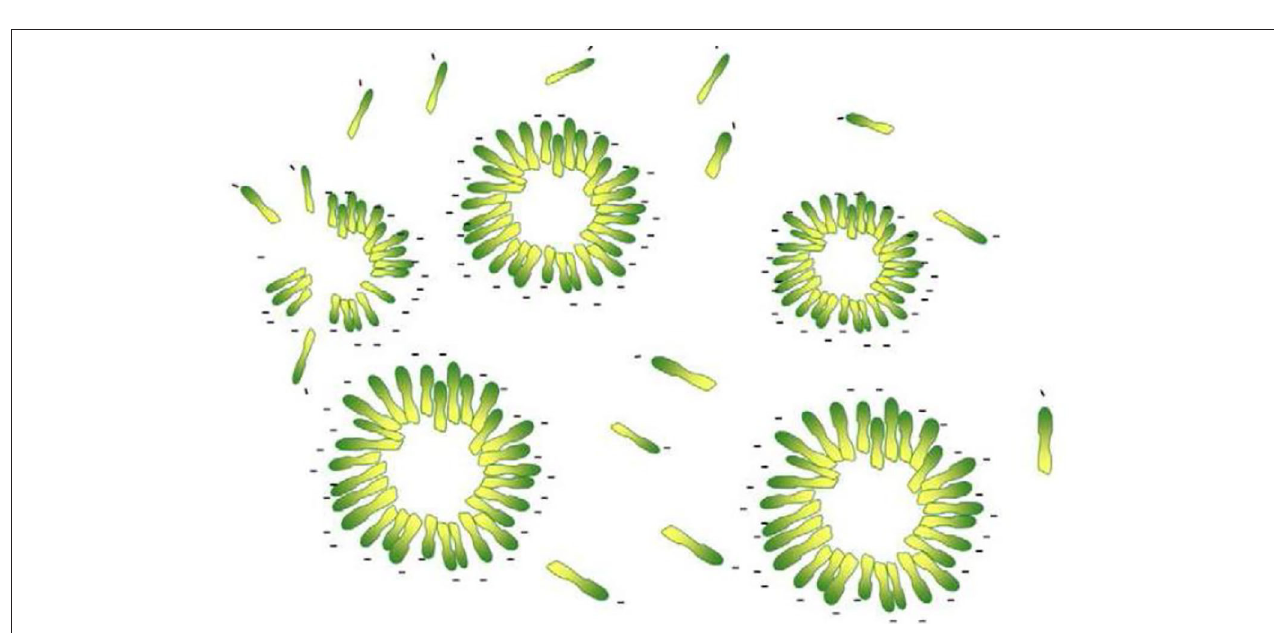
FIGURE 9 | Humic acid micelles (Salati et al.,